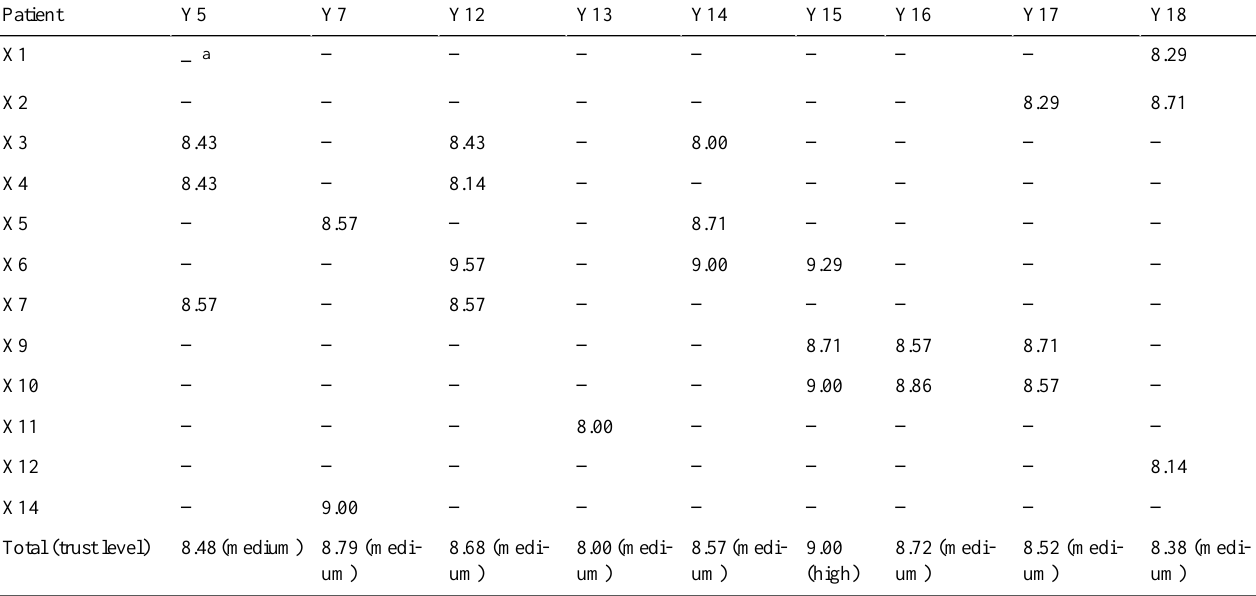
Table 8. Trust value matrix on patient (X) ratings of articles posted by physicians